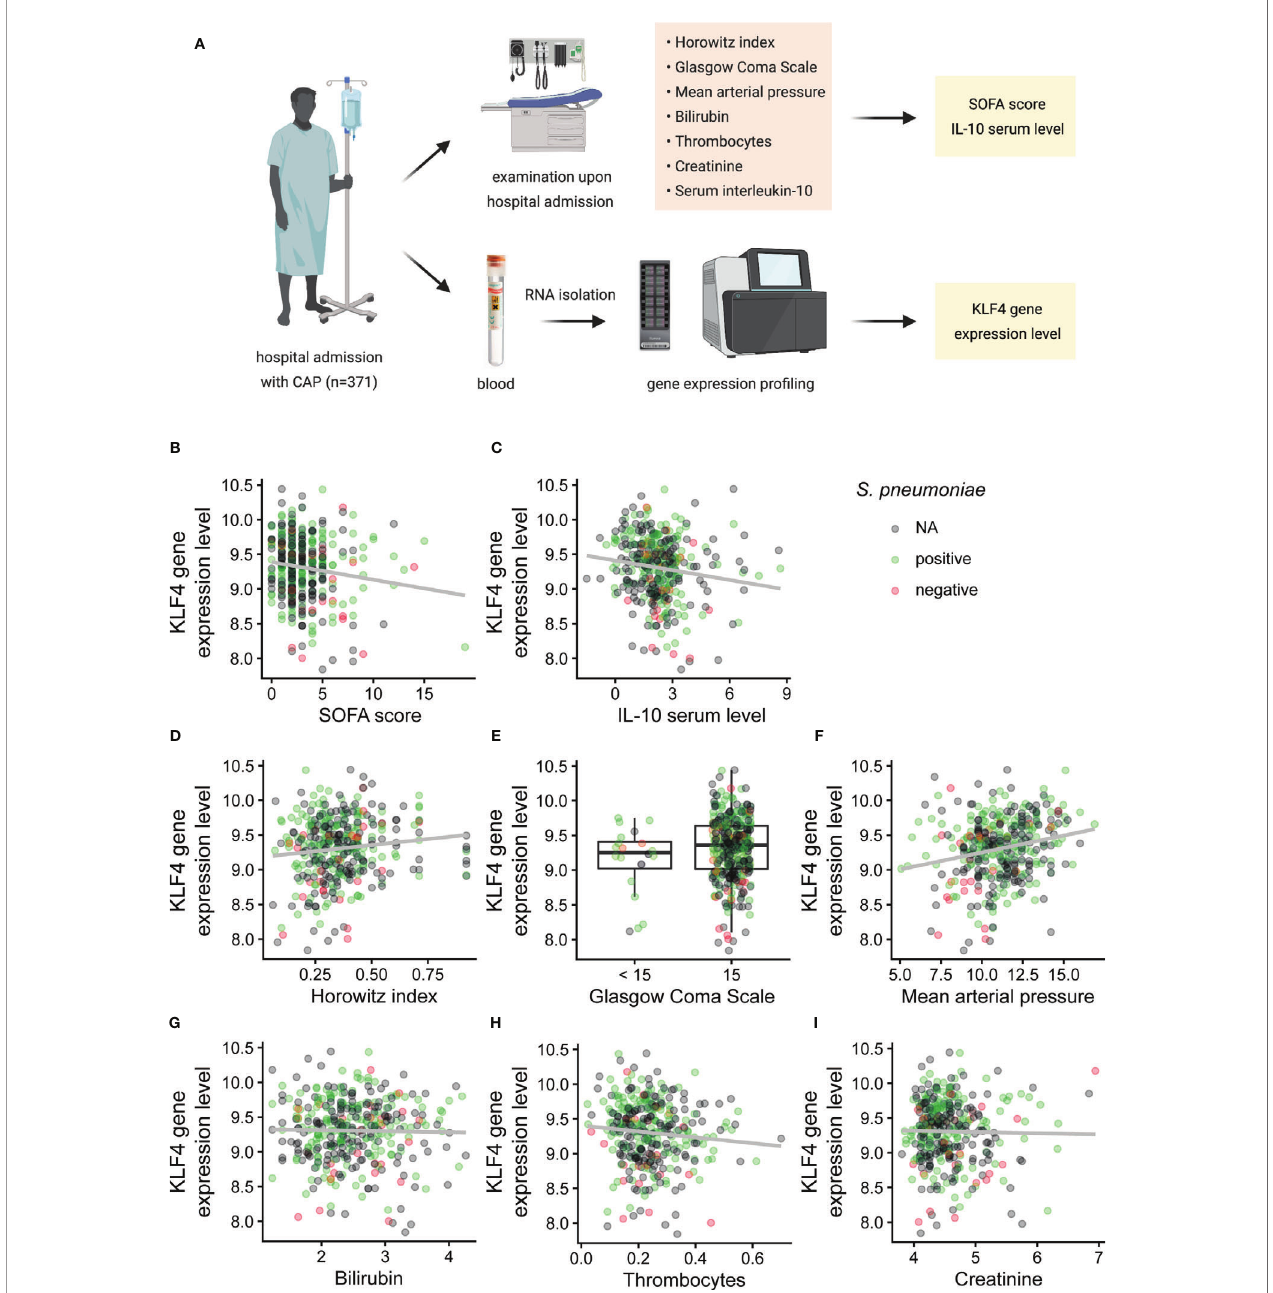
FIGURE 4 | Correlation of KLF4 gene expression levels in peripheral blood with SOFA score, SOFA subscores and serum levels of IL-10 in patients with community-acquired pneumonia at admission to hospital. Horowitz index (oxygenation index, PaO 2 /FiO 2 ), Glasgow Coma Scale, mean arterial pressure, total bilirubin, thrombocyte count, serum creatinine, IL-10 serum levels and KLF4 gene expression levels in peripheral blood were determined in 371 patients with community-acquired pneumonia (CAP) at presentation to hospital (A) . KLF4 gene expression levels (in copies per cell, vertical axis) were correlated with the SOFA score (in points) (B) , the IL-10 serum concentration (in pg/ml, values natural log-transformed) (C) and the SOFA subscores: Horowitz index (in kPa, original values divided by 100) (D) , Glasgow Coma Scale (in points, values split into the categories 15 points or below 15 points) (E) , mean arterial pressure (in kPa) (F) , serum bilirubin (in µmol/l, values natural log-transformed) (G) , thrombocyte count (in millions/µl) (H) , and serum creatinine (in µmol/l, values natural log-transformed) (I) . Green dots represent patients with positive testing for S. pneumoniae (blood culture, culture of respiratory material, or urinary antigen testing), red dots represent patients with negative testing for S. pneumoniae , and grey dots represent patients without testing for S. pneumoniae (N.A.). Graphs show scatter plots with trendline (B – D, F – I) , or boxplots with interquartile range (E) . Data points overlaying the boxplots are scattered horizontally. FiO 2 , fraction of oxygen in the inhaled air (in percent); PaO 2 , oxygen partial pressure in capillary or arterial blood (in